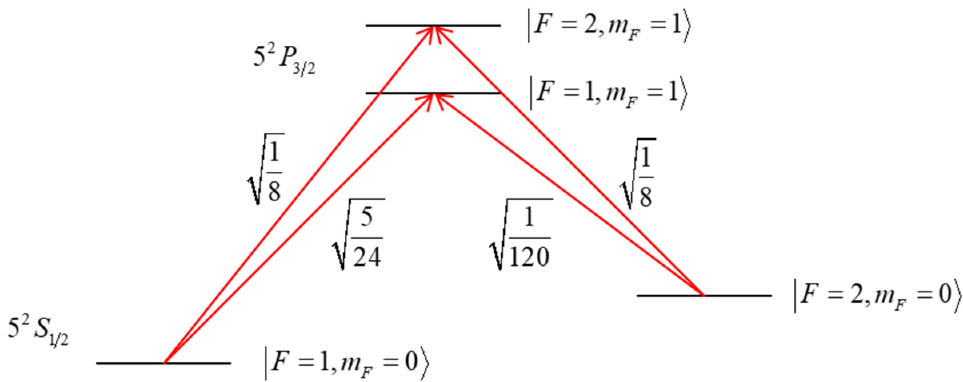
Figure 13. Matrix elements relevant to the Raman transition between g and e